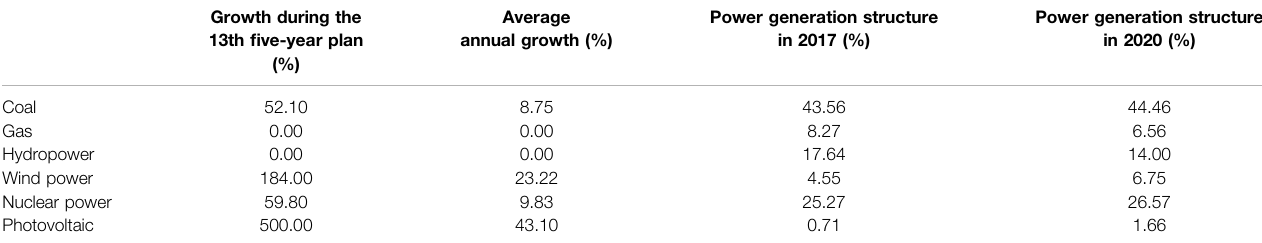
TABLE 2 | Changes in power generation structure.